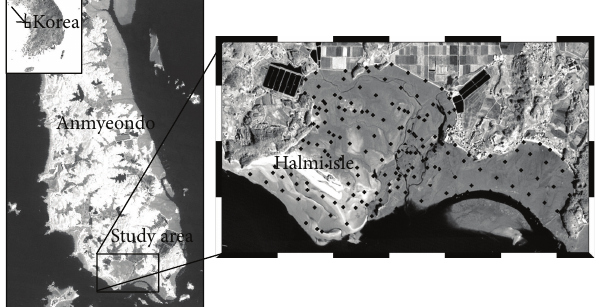
Figure1:Locationofthecasestudyarea.Blackdotsdenotesampling